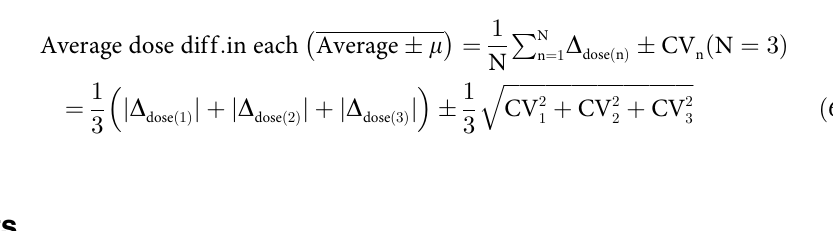
PLOS ONE | https://doi.org/10.1371/journal.pone.0266110 March 29,